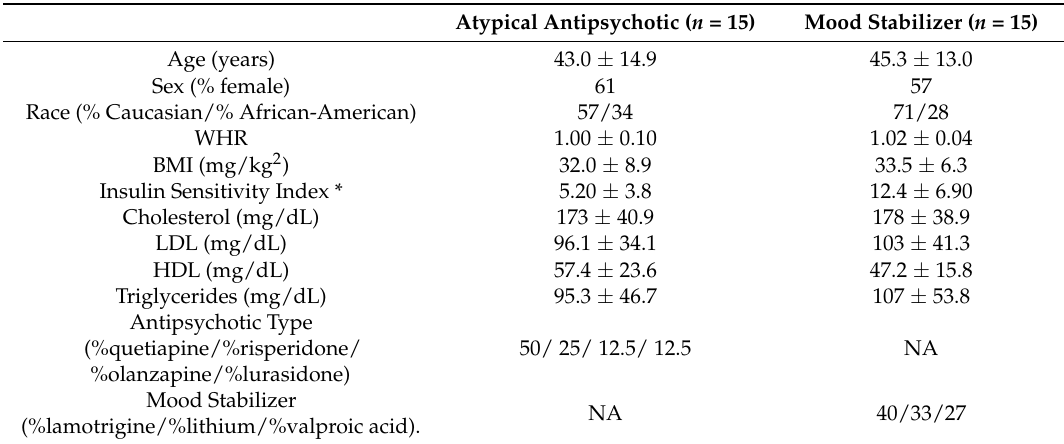
Table 1. Sample set characteristics.